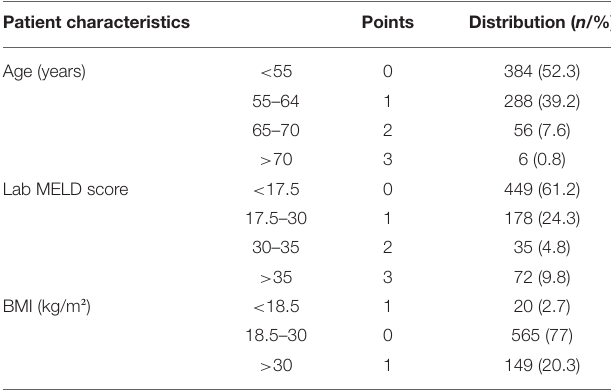
TABLE 2 | Preoperative patient characteristics identified as independent predictors of 90-day mortality after liver transplantation (LT) and resulting scores. Patient